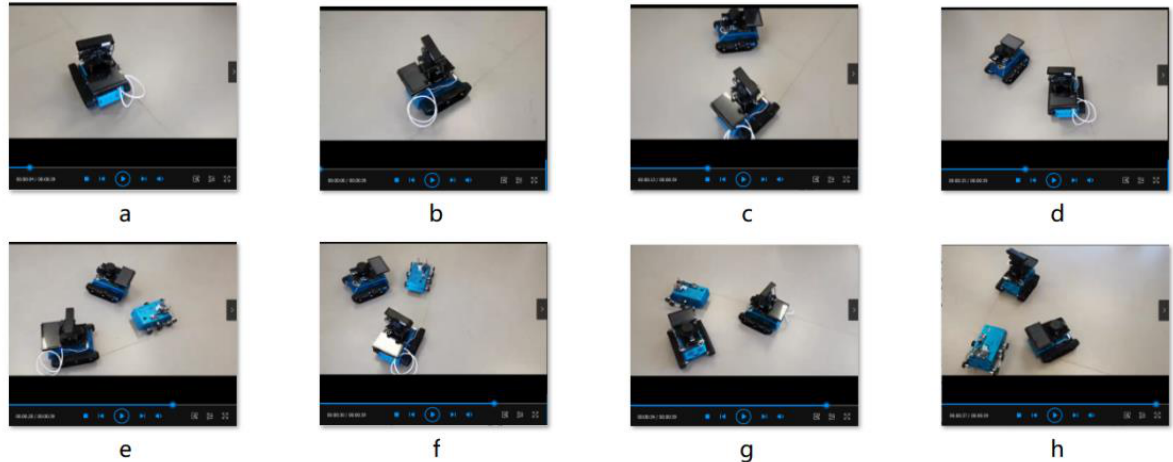
Figure 7. Screenshot of the testing video. ( a , b ) An example of the target in the screen. ( c , d ) An example of one similar object and the target in the screen. ( e ) An example of two similar objects and the target in the screen. ( f – h ) An example of two similar objects and the target in the screen in different angles.